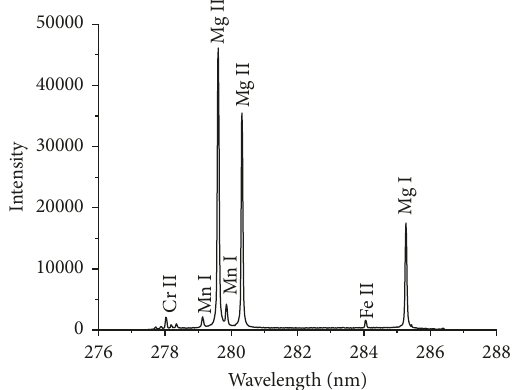
Figure 10: The SP-LIBS spectrum of a coral skeleton with identified trace elements, collected from Inani Beach, Cox’s Bazar